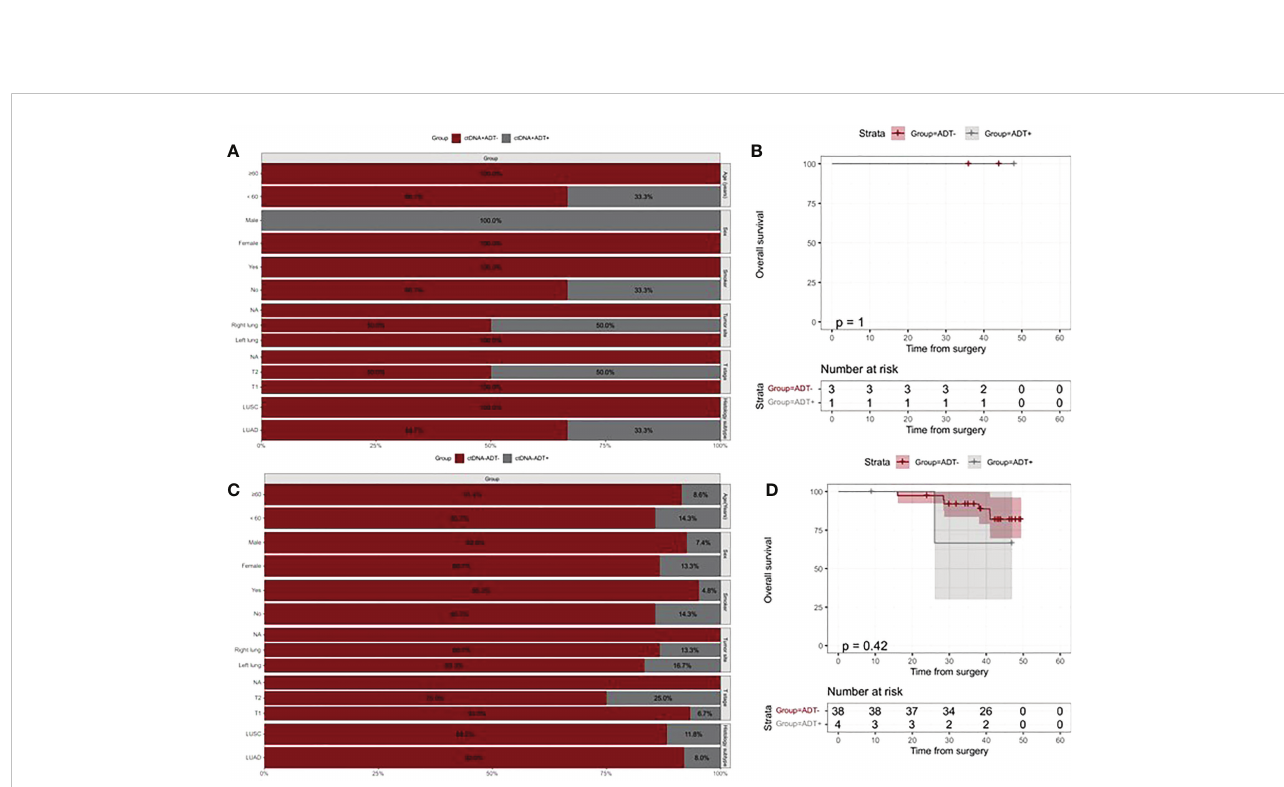
FIGURE 5 Kaplan – Meier analysis of overall survival according to ADT and postoperative ctDNA status. (A) The distribution of clinicopathologic characteristics for patients who received vs patients who did not receive ADT in the ctDNA-positive group. (B) Kaplan-Meier curve showing RFS strati fi ed by ADT in the ctDNA-positive group. (C) The distribution of clinicopathologic characteristics for patients who received vs patients who did not receive ADT in the ctDNA-negative group. (D) Kaplan-Meier curve showing RFS strati fi ed by ADT in the ctDNA-negative group.